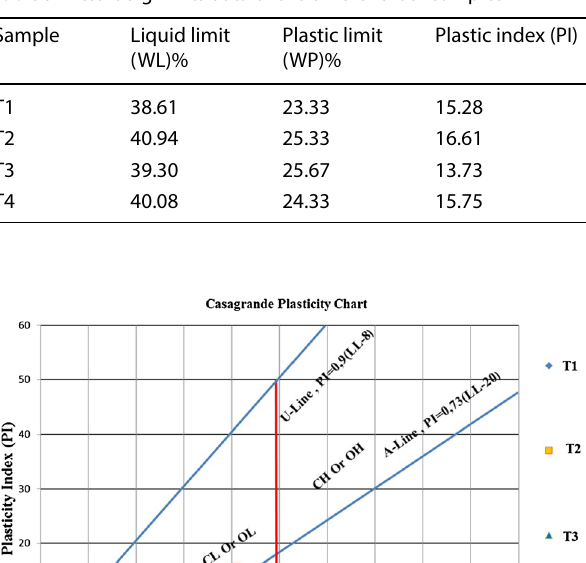
Table 4 Ranges of geochemical compositions of clay raw materials used in the brick and tile industry in 11 European countries (Austria, France, Netherlands, Hungary, Italy, Greece, Denmark, Belgium, UK, Switzerland, Germany) (European Commission 2007) [30] Chemistry (wt-%)